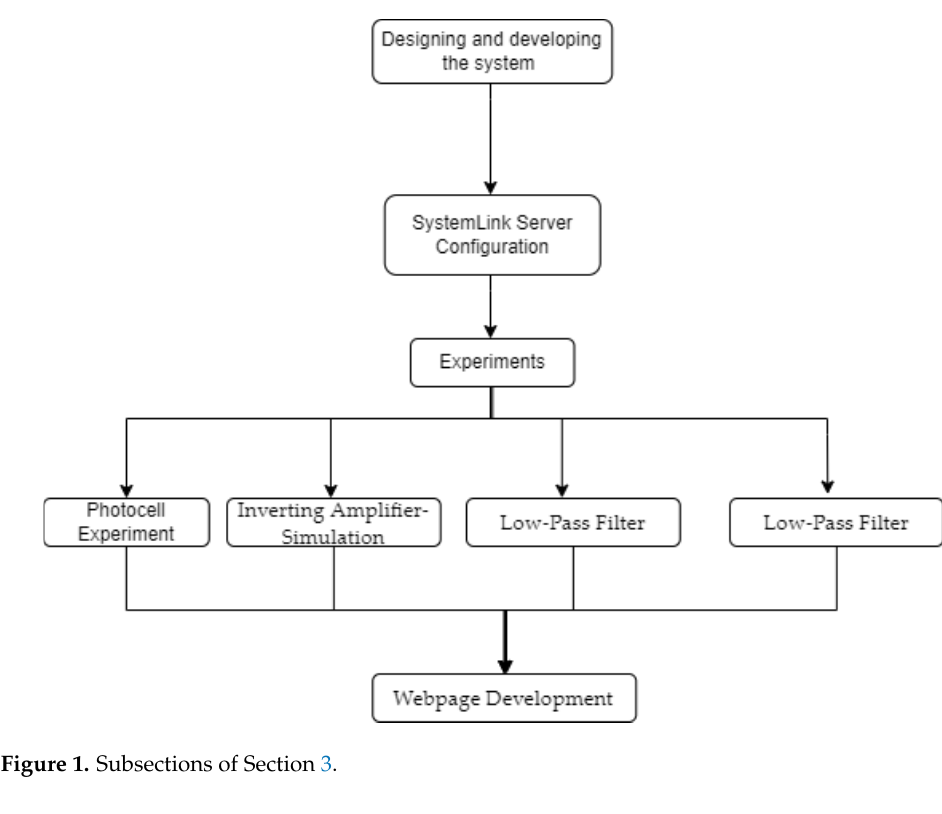
Figure 1. Subsections of Section 3.